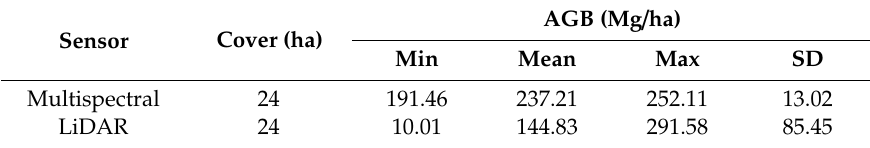
Table 3. Calculated AGB from multispectral and LiDAR data.